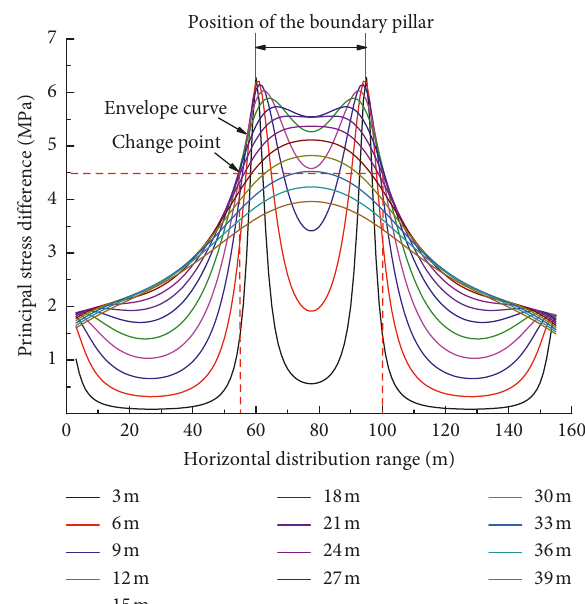
Figure 5: Principal stress difference curves at different